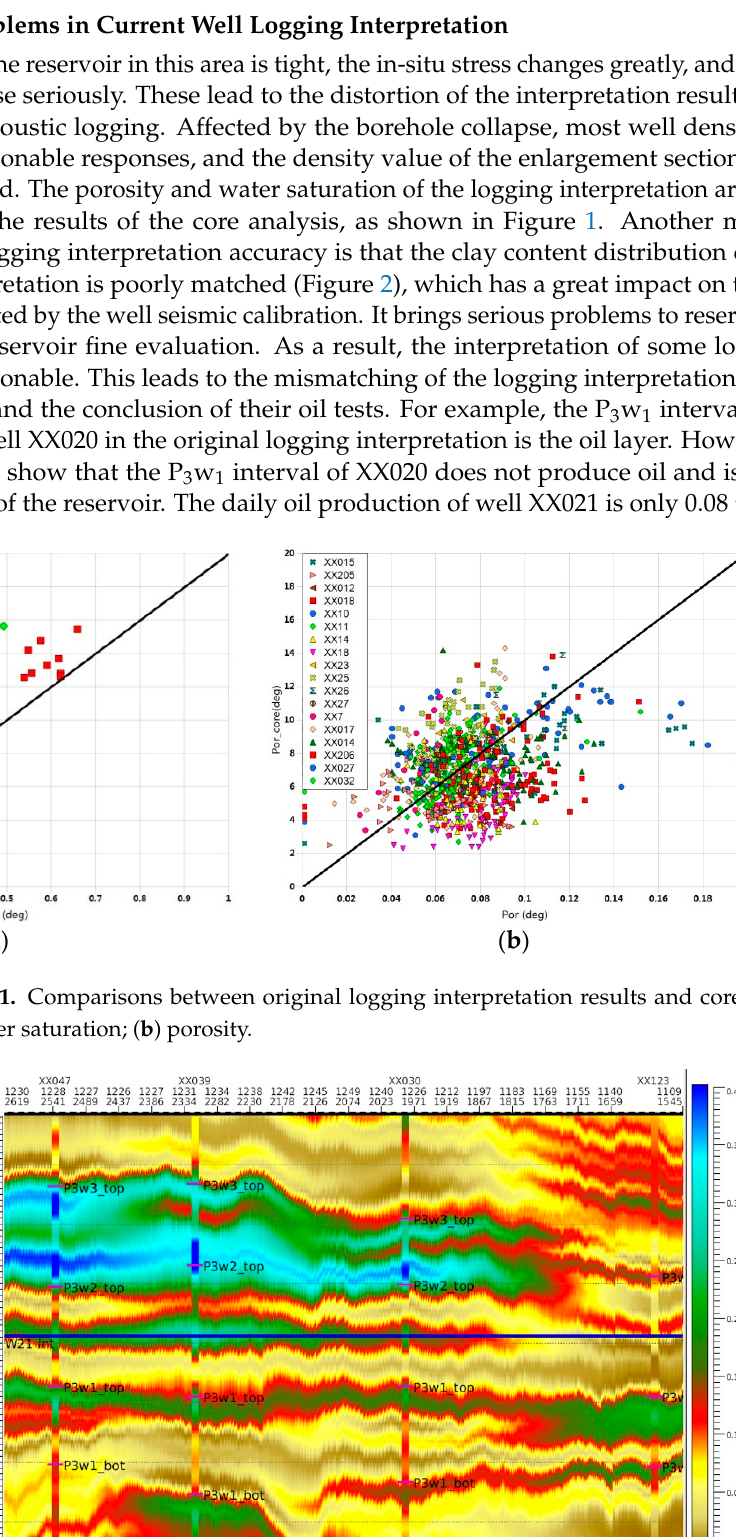
( b ) Figure 3. histograms of the porosity for logging interpretation: ( a ) vertical wells; ( b ) horizontal wells (original). The blue-filled histogram is the cumulative distribution of all wells.